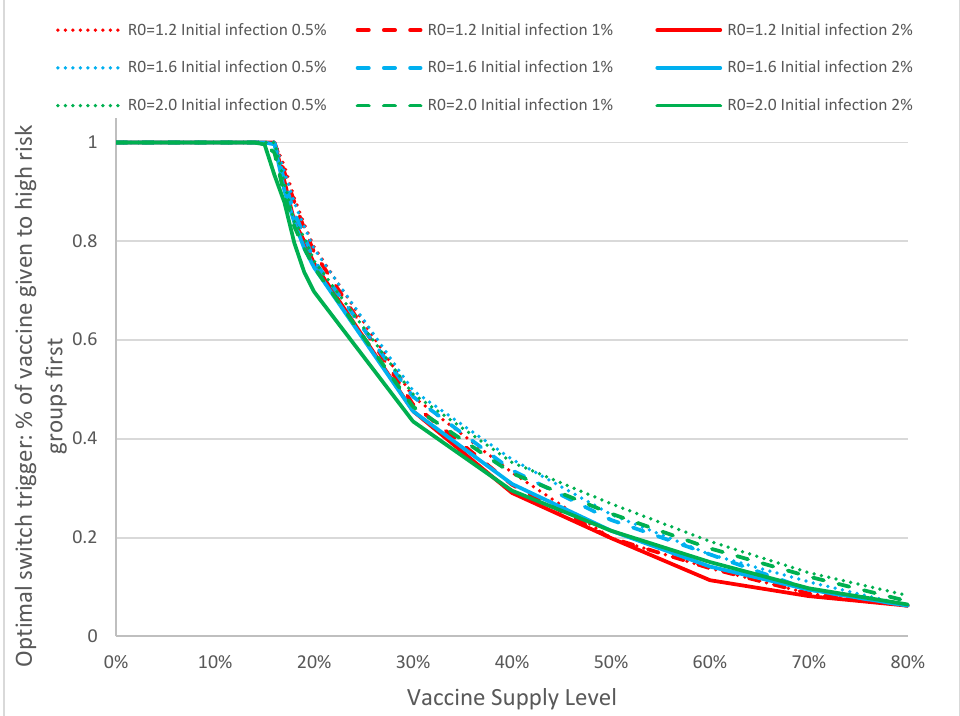
Figure 9. In this panel we show the optimal switch trigger (percentage of vaccine dispensed to